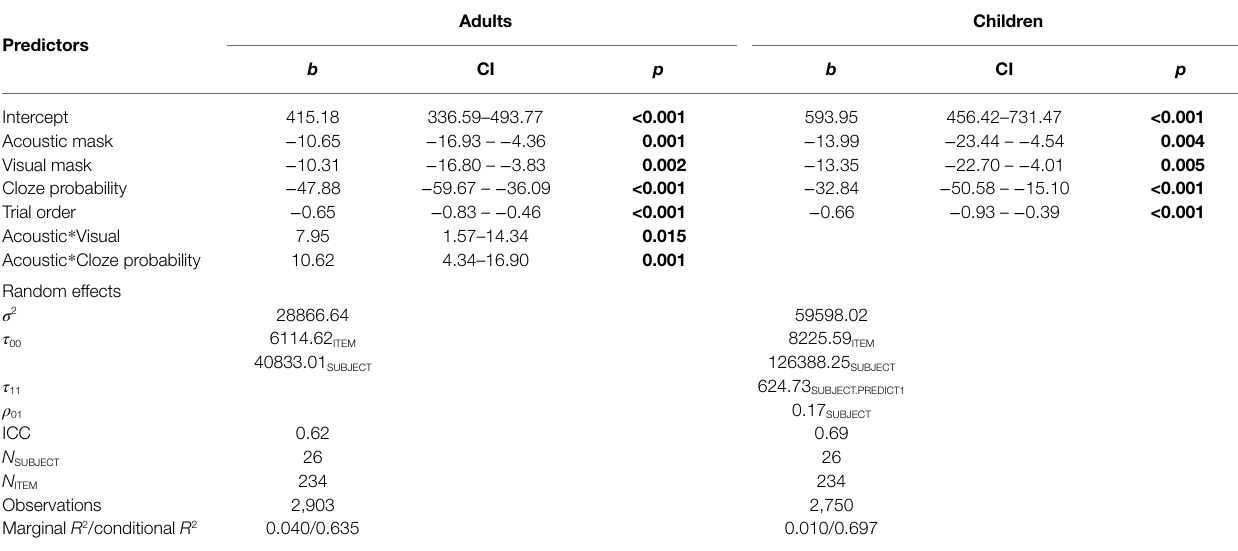
TABLE 3 | Optimized linear mixed-effects models for adults and children, respectively, with reaction times as response.